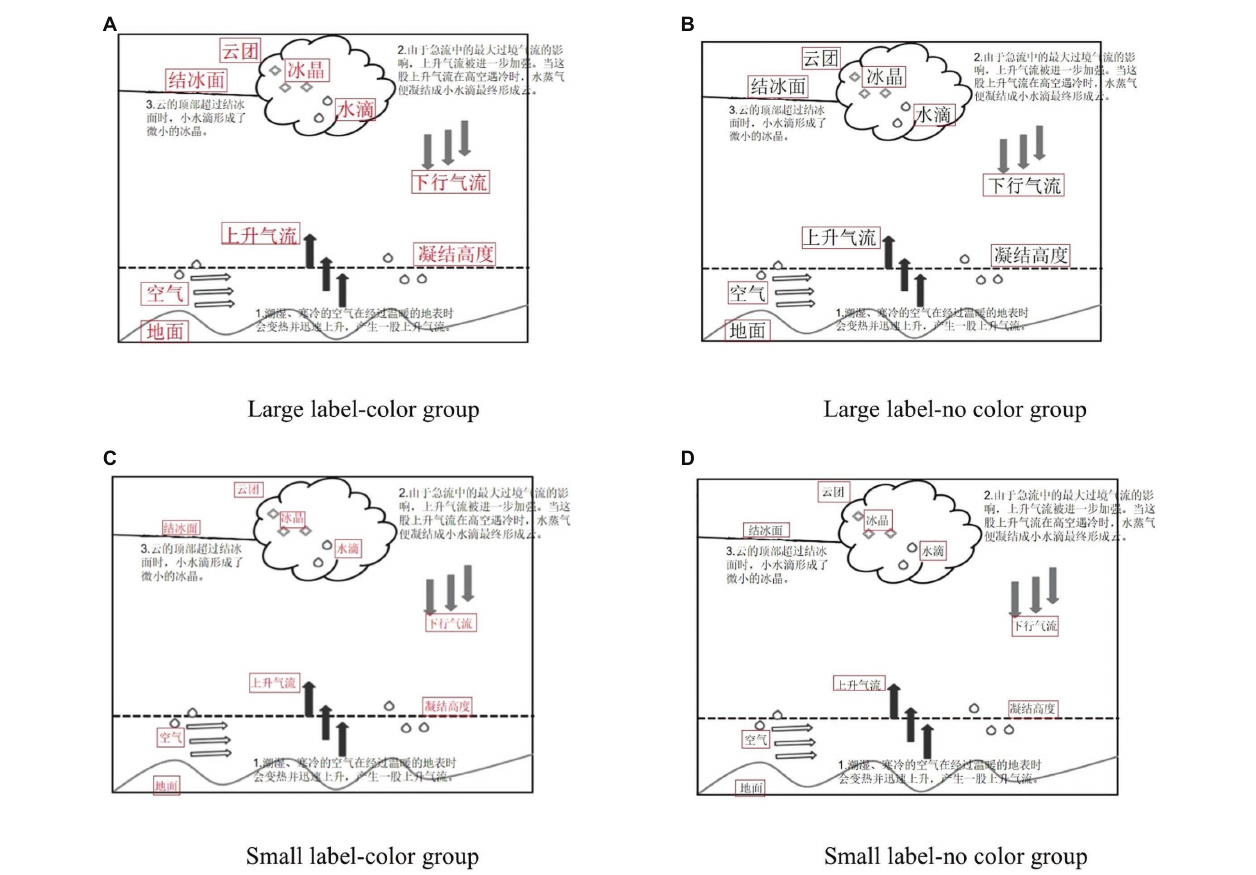
FIGURE 1 | Examples of learning materials. (A) Large label-color group. (B) Large label-no color group. (C) Small label-color group. (D) Small label-no color